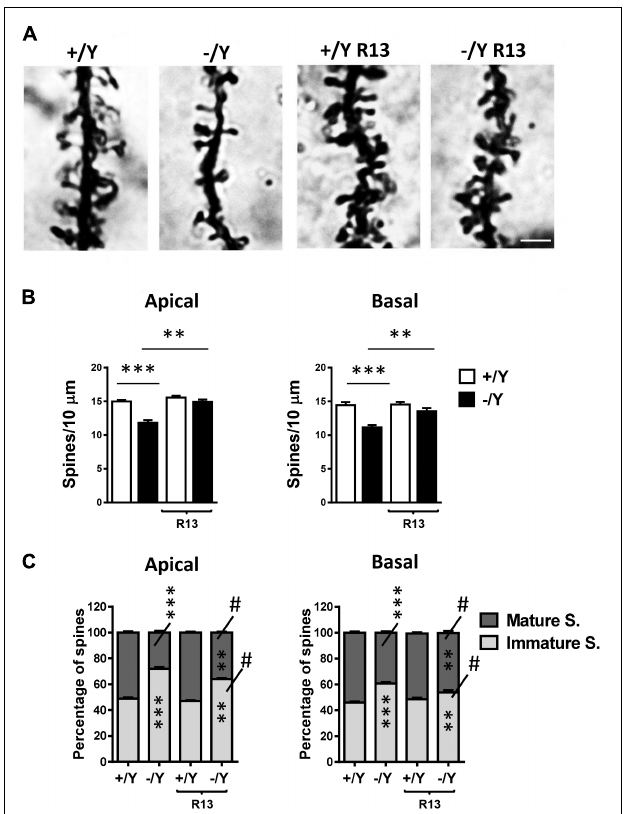
FIGURE 7 | Effect of treatment with R13 on dendritic spines in the perirhinal cortex of Cdkl5 − /Y mice. (A) Images of Golgi-stained dendritic branches of layer II-III perirhinal neurons of a P50 Cdkl5 +/Y and a Cdkl5 − /Y mouse, and of a Cdkl5 − /Y mouse treated with R13. Scale bar = 1.5 µ m. (B) Dendritic spine density (number of spines per 10 µ m) in apical and basal dendrites from vehicle-treated Cdkl5 +/Y ( n = 4) and Cdkl5 − /Y ( n = 4) mice, and Cdkl5 +/Y ( n = 4) and Cdkl5 − /Y ( n = 4) mice treated with R13. (C) Percentage of immature and mature spines in relation to the total number of protrusions of layer II-III perirhinal neurons in mice as in (B) . Values represent mean ± SE. ∗∗ P < 0.01; ∗∗∗ P < 0.001; # p < 0.01 compared to untreated Cdkl5 − /Y mice in (C) [data in (B) Fisher’s LSD test after two-way ANOVA; data in (C) Chi-squared test].